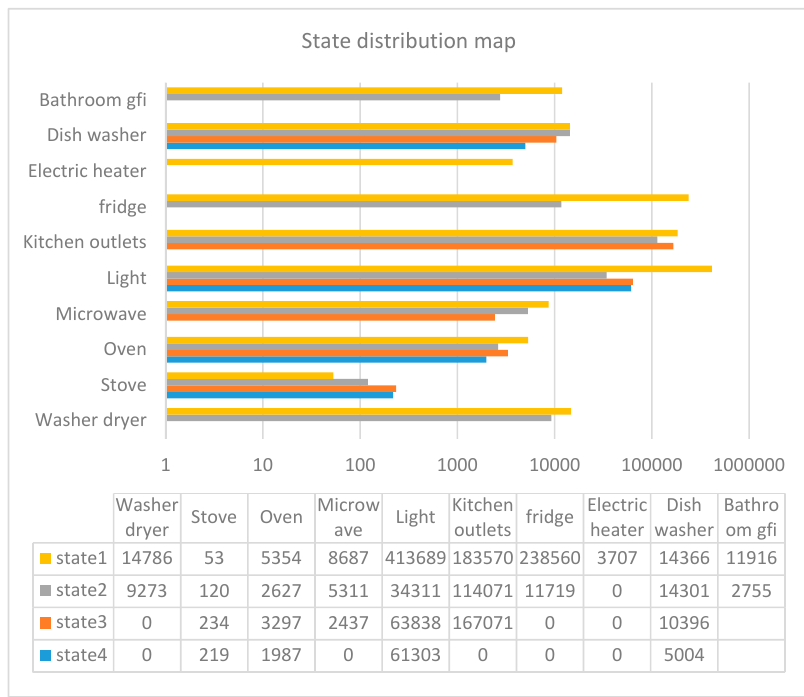
Figure 9. State distribution diagram.